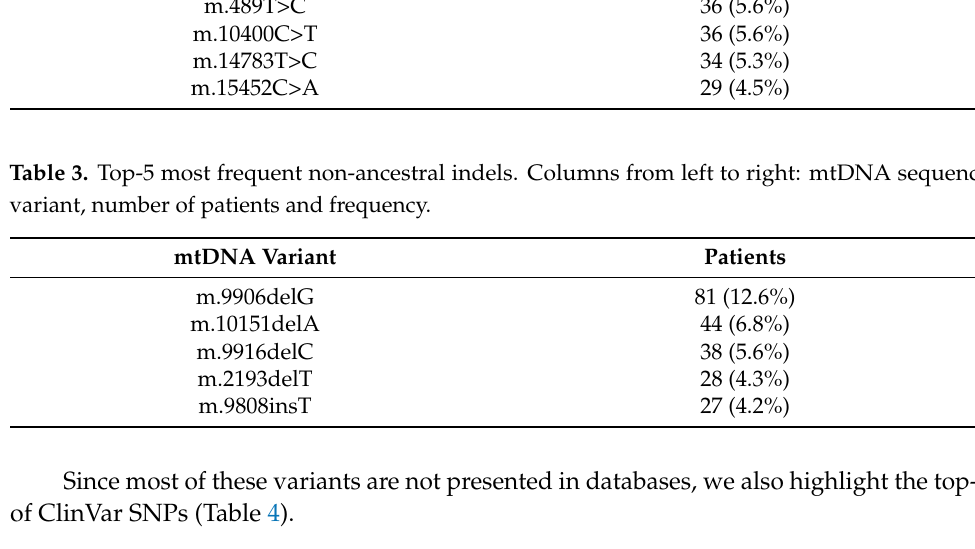
Table 4. Top-5 most frequent non-ancestral SNPs presented in ClinVar database. Columns from left to right: mtDNA sequence variant, variant ID (rs), variant ID (ClinVar), clinical significance (ClinVar), diagnosis (ClinVar), number of patients and